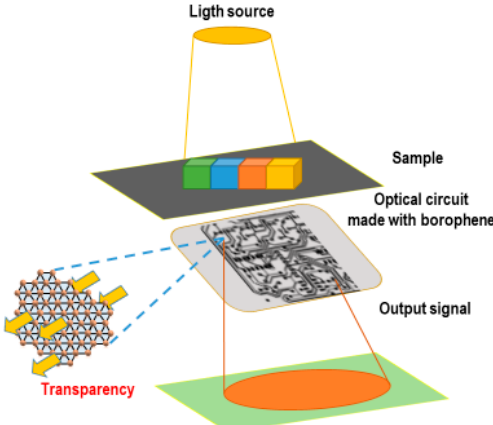
Figure 3. Optical coe ffi cients linked to the anisotropy of the structure of borophene make it ideal for optical